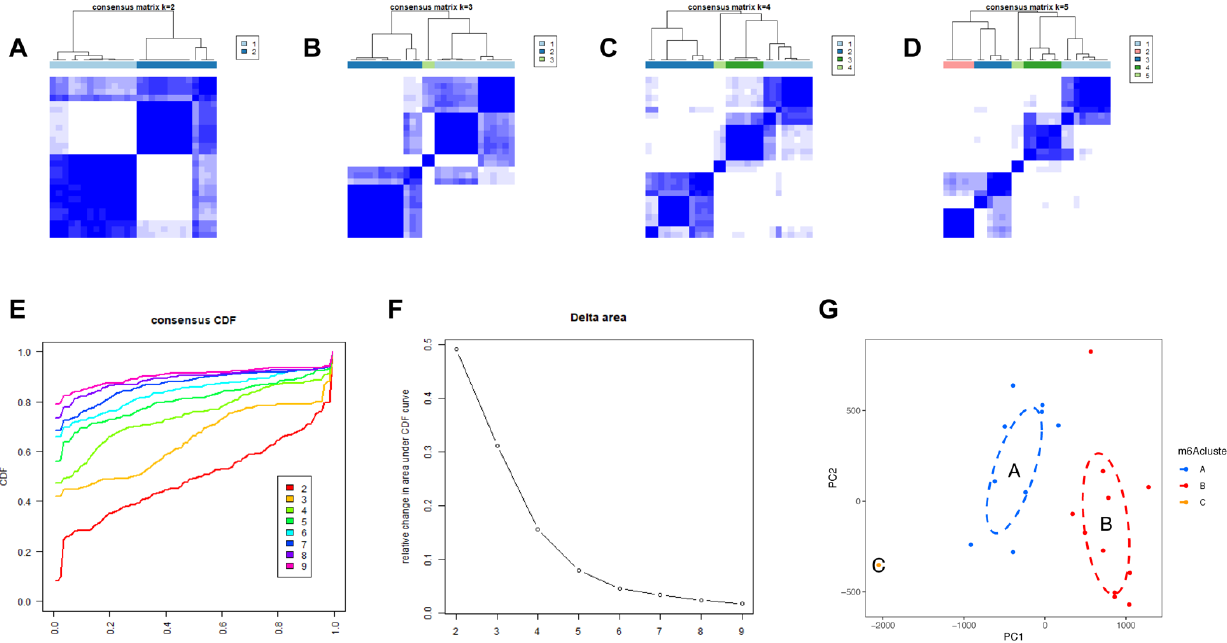
Figure 6. Identification of three molecular subtypes through unsupervised clustering of significant m6A regulators. ( A – D ) Distinct m6A patterns based on the candidate genes. ( E ) The CDF graph. ( F ) Relative change of the area under the CDF curve (k = 2– 9). ( G ) Principal component analysis of the candidate genes in the three subtypes.